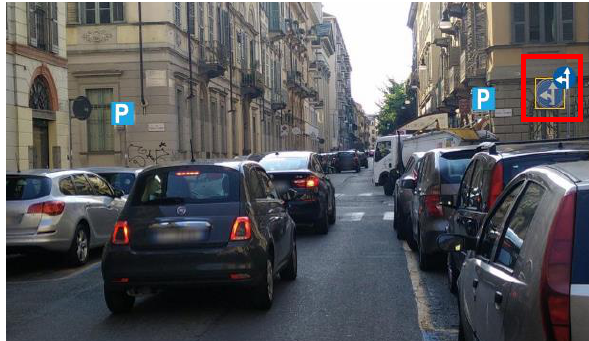
Figure 6. Screenshot from the Mapillary web application where, both the traffic sign captured in the frame and its representation (generated by the Mapillary semantic segmentation tool) are displayed in the red rectangle.